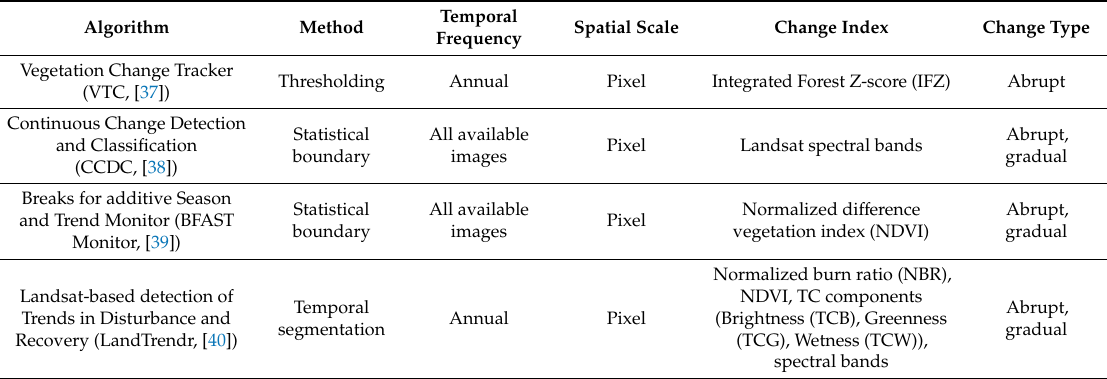
Table 1. Common publicly available and automated change detection algorithms using LTS. See Table A1 for a description of spectral